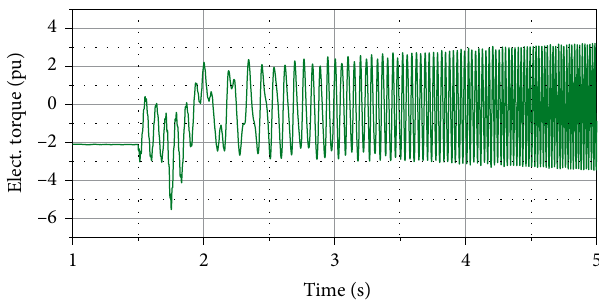
Figure 4: Electrical torque characteristics due to SSR in the wind